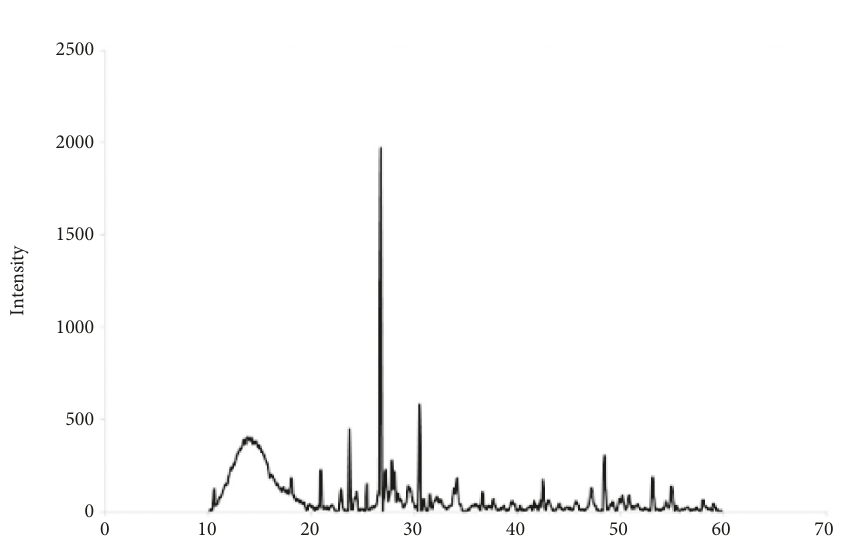
Figure 5: XRD pattern for GGBS.